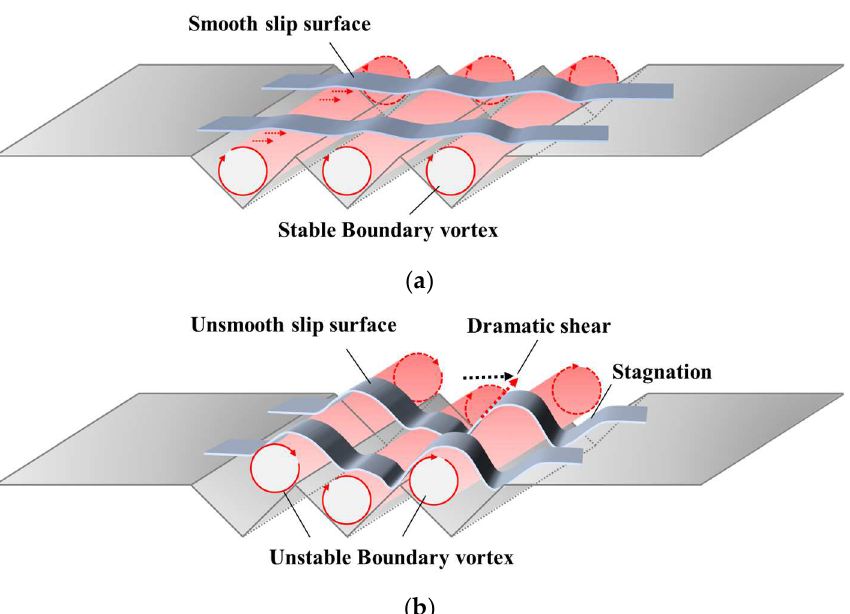
Figure 1. Schematic diagram of the slip surface over transverse grooves. ( a ) Stable boundary vortex; ( b ) unstable boundary vortex.